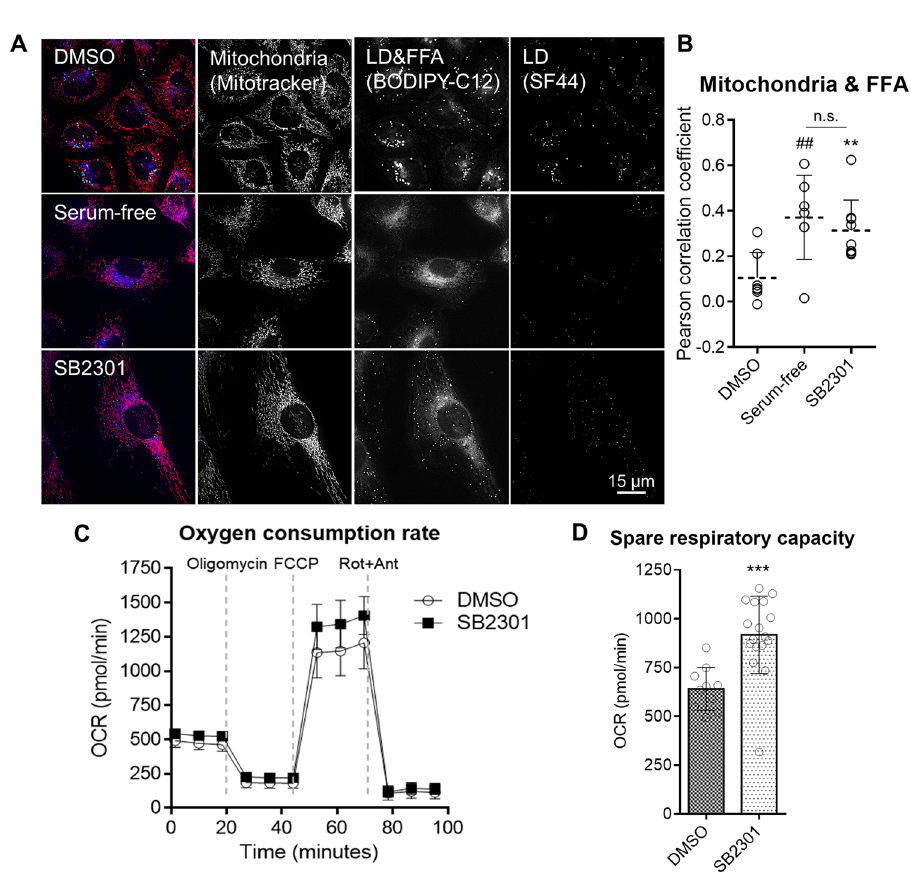
Fig. 5 Cellular consumption of FFA is increased upon SB2301 treatment. A Representative live-cell fl uorescence images of FFA pulse-chase assay with BODIPY-labeled FFA. 2 μ M of BODIPY-C12 was treated on HeLa cells for 21 h. The cells were then treated with 5 μ M of SB2301 or incubated in a serum- free medium for an additional 24 h. Mitochondria were stained with Mitotracker, and LD was stained with SF44. The images were merged by designating red for mitochondria, blue for BODIPY-C12, and green for LD. B Pearson correlation coef fi cient was calculated to demonstrate the colocalization of BODIPY-C12 and Mitotracker signals. Images were selected randomly from biological triplicates. All data are represented as dot plots with the mean ± SD. Data were analyzed using an unpaired t -test. ** P = 0.0052 vs. DMSO, ## P = 0.0070 vs. DMSO. C Oxygen consumption rate measurement. AML12 cells were treated with 20 μ M of SB2301 for 24 h. All data are represented as the mean ± SD. Rot + Ant; rotenone + antimycin A. D Calculated spare respiratory capacity (maximum respiratory capacity — basal respiration) from C . All data are represented as dot plots with the mean ± SD, ( n = 4). Data were analyzed using an unpaired t -test. *** P =